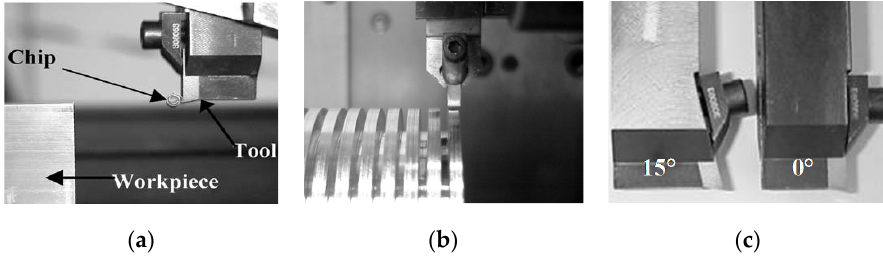
Figure 1. Experimental setup of orthogonal cutting tests: ( a ) planar machining, ( b ) turning, and ( c ) cutting tools with two rake angles (0° and 15°) [11].